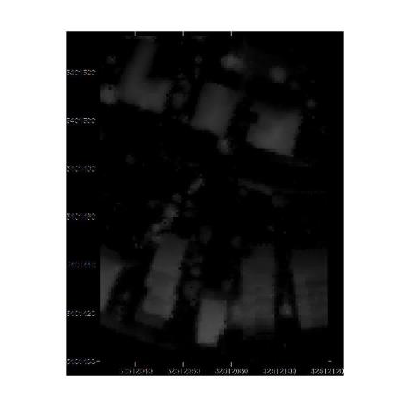
Figure 8. DSM of the region